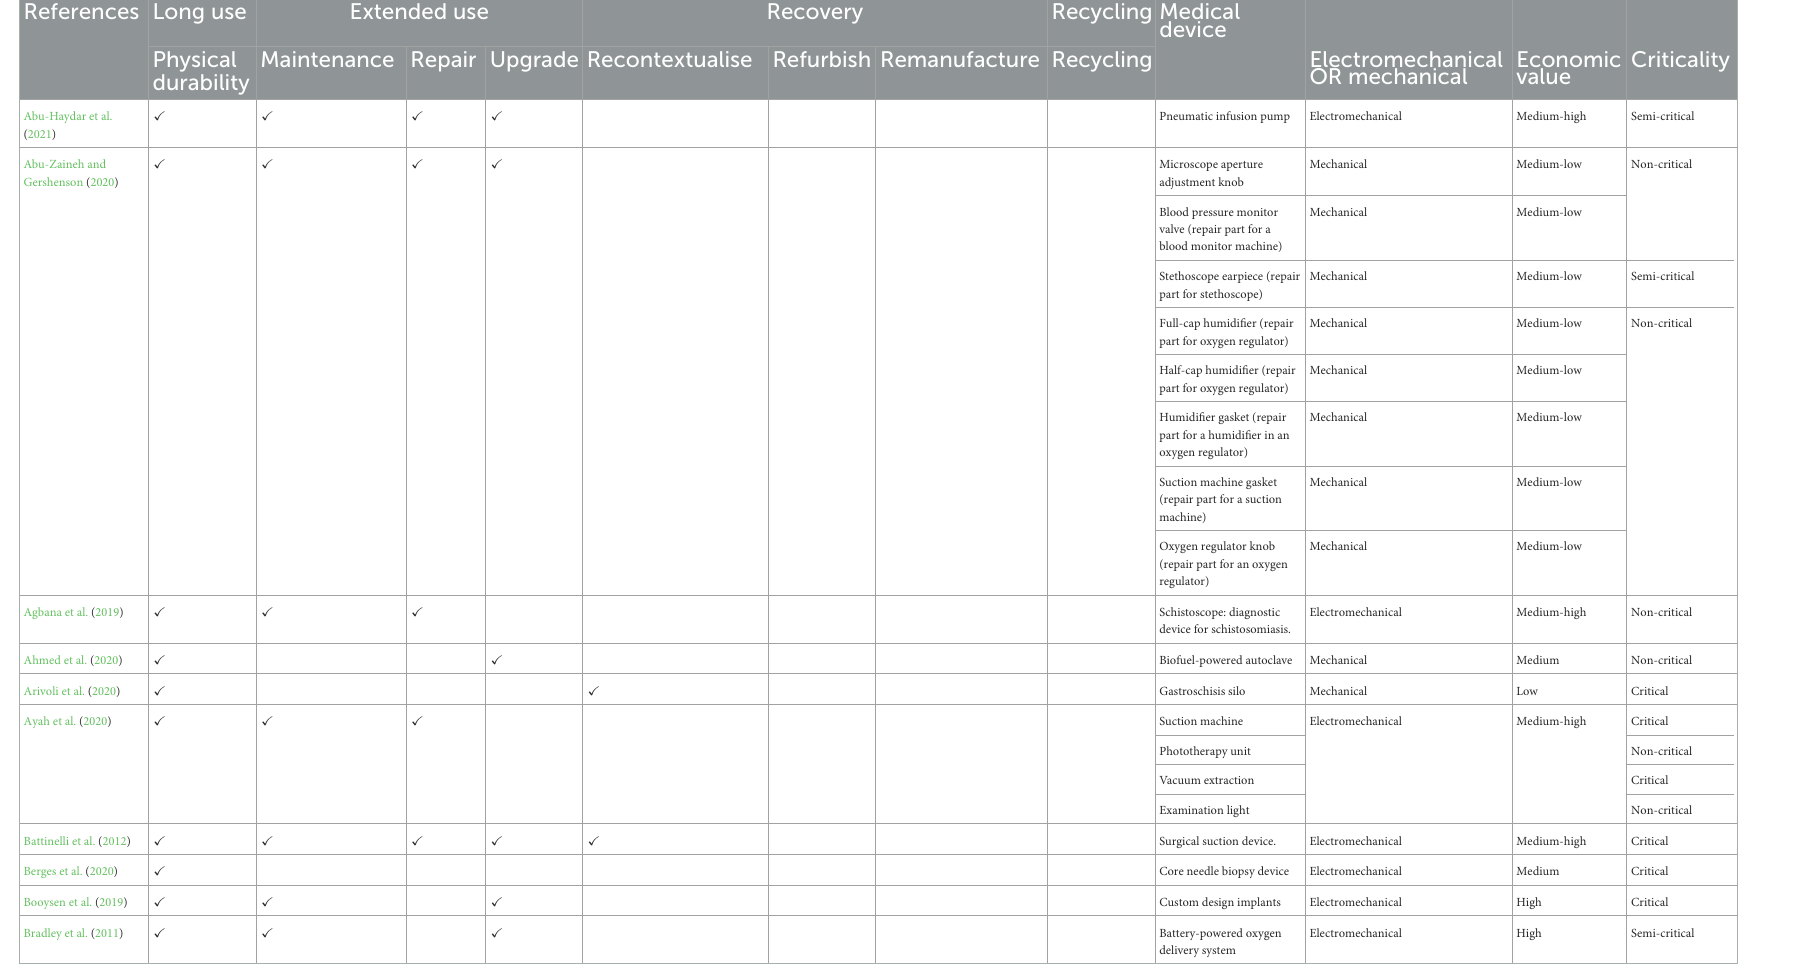
TABLE 3 The CE principles applied in the design of medical devices for LRS in SSA as pinpointed in the literature. References Long